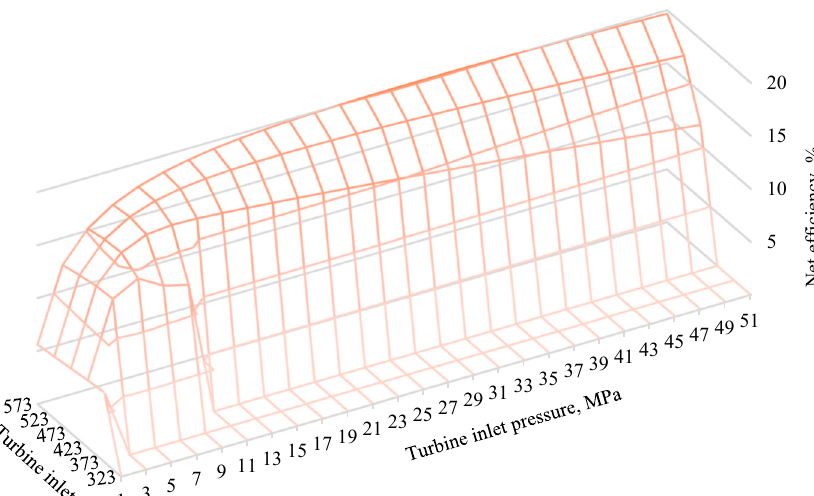
Figure 10. Simple Rankine cycle efficiency for R124 and different inlet temperatures and pressures.